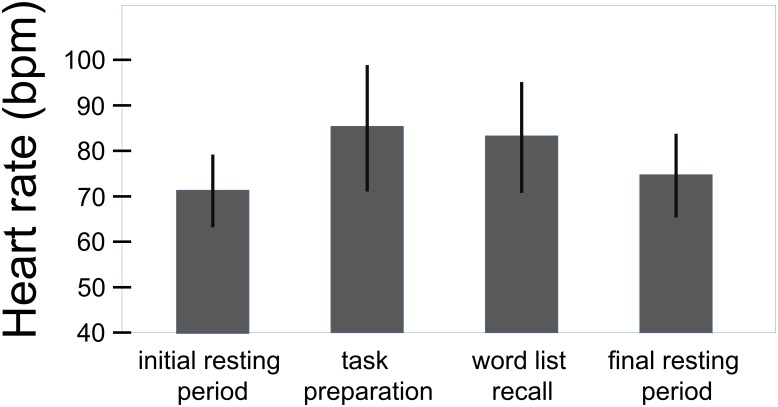
Overall effect of the challenge on the heart rate (total sample, n = 70). Whiskers represent standard deviations. (F(3,207) = 76.8, p < 0.001, η2 = 0.527).